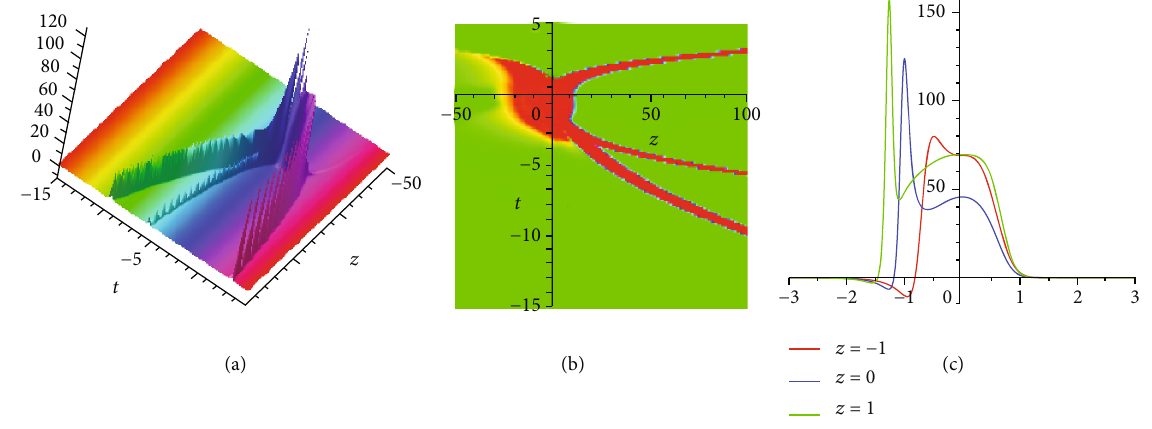
Figure 24: Plots of lump-three kink solutions (87).